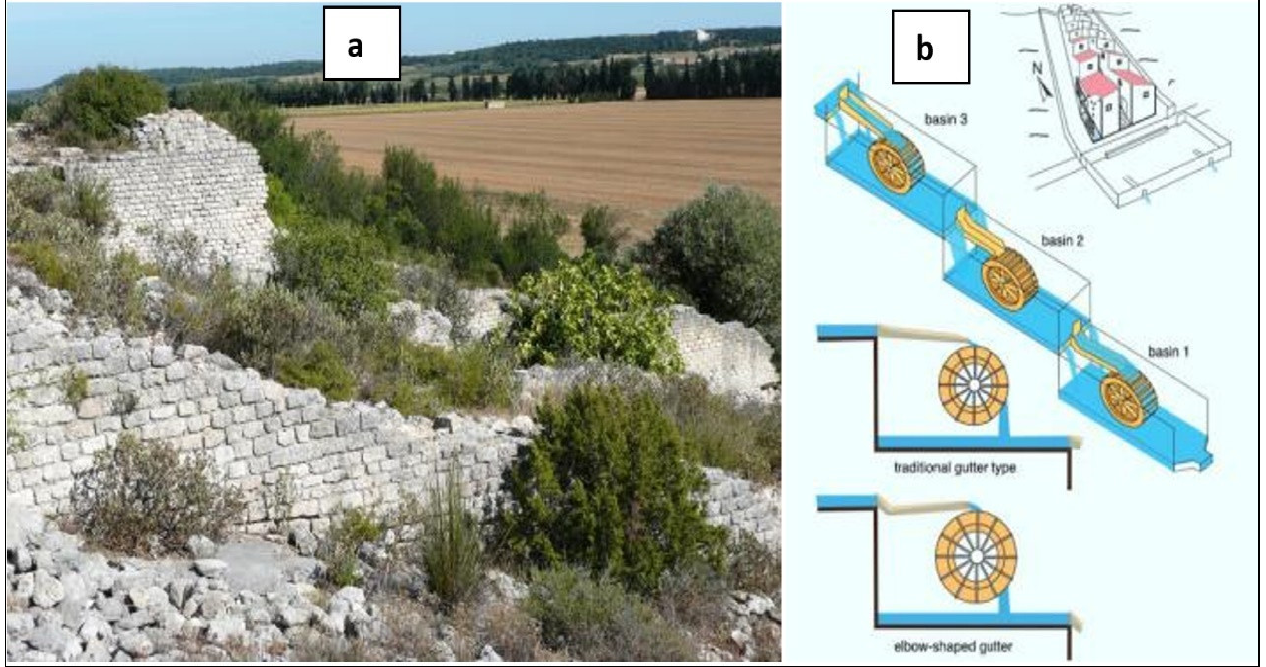
Figure 5. ( a ) The southern France Barbegal water mill complex; ( b ) its schematic diagram (adapted from [21,22]).